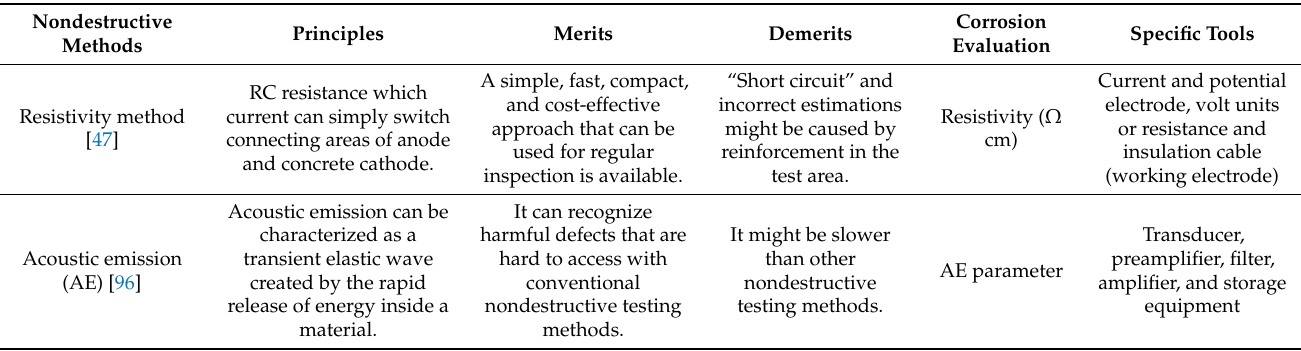
Table 3. Corrosion monitoring